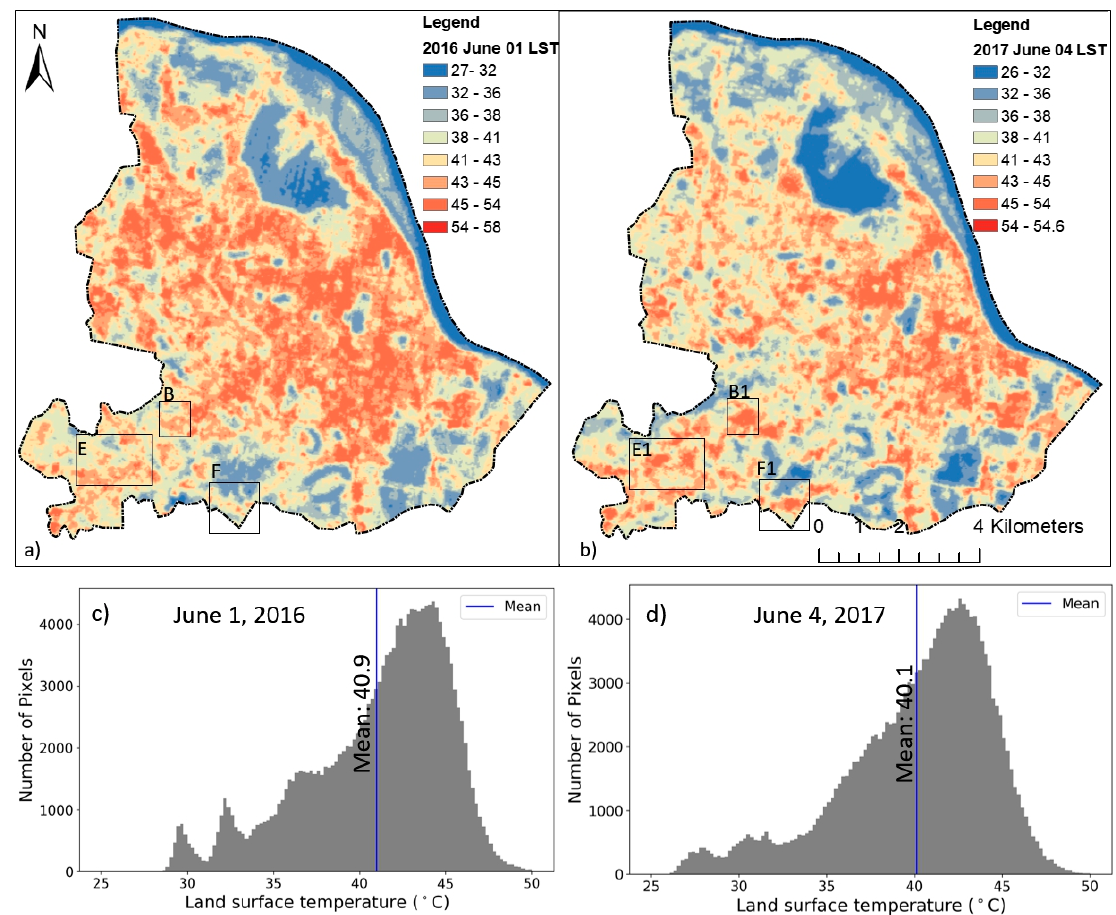
Figure 6. Land surface temperature (LST) maps of inner Hanoi City for ( a ) 1 June 2016 and ( b ) 4 June 2017; and their corresponding histogram distributions in ( c ) and ( d ), respectively. Three areas with substantial changes in LST between two hottest days are randomly chosen and labeled as B, E, and F in both ( a , b ). The pixel size is 30 × 30 m. Table 7. Number of pixels (1 pixel = 30 × 30 m) and mean LST for the three randomly chosen areas B, E, and F on the two hottest days in 2016 and 2017, and the difference in LST between the two hottest days.